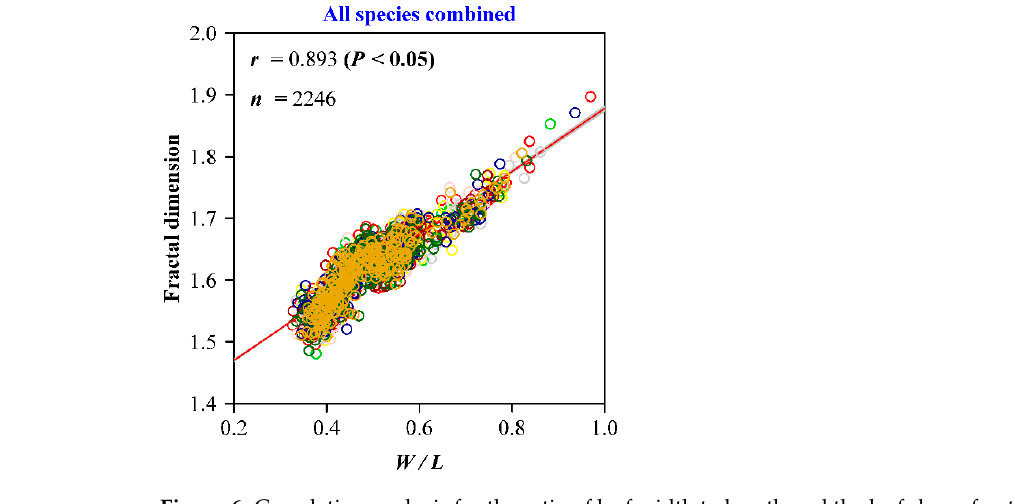
Figure 6. Correlation analysis for the ratio of leaf width to length and the leaf shape fractal dimension for all species combined. Here, r is the correlation coefficient, and n represents the sample size. However, except for leaf length, other leaf measures related to leaf shape and size (including leaf fresh mass, area, the perimeter/area ratio, the leaf fresh mass/area ra- tio) were not correlated, or were weakly correlated, with the leaf fractal dimension (FD) (Table 2). Leaf roundness index was positively correlated with FD in six out of nine species, although most relatively weakly (Table 2). Correspondingly, leaf roundness index was also positively correlated with the W / L ratio in five out of the six species (Table 2). However, the correlation coefficients between FD and leaf roundness index, and between roundness index and the W / L ratio, are both lower than that between FD and the W / L ratio. Table 2. The correction coefficients between leaf shape fractal dimension (FD) and each of the following leaf indices and the corresponding p